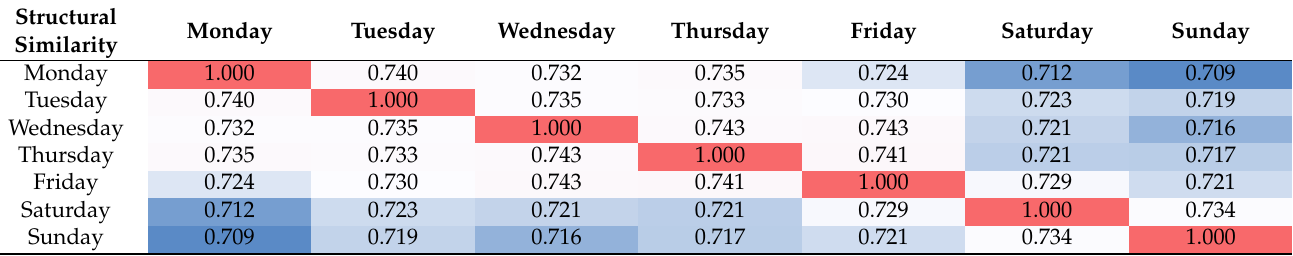
Table 3. Structural similarity of the OD matrixes in Shenzhen.